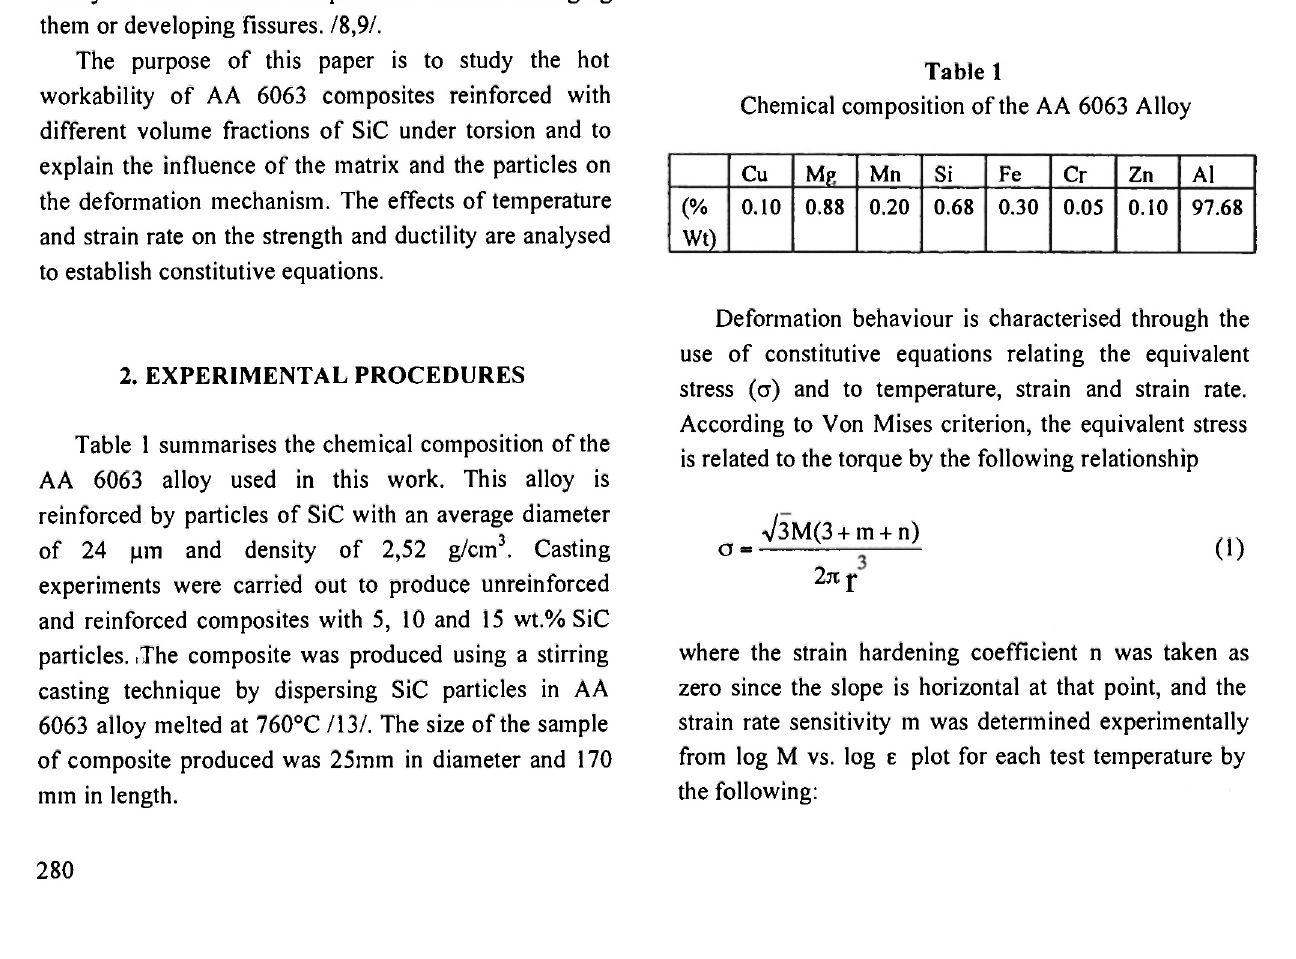
Chemical composition of the AA 6063